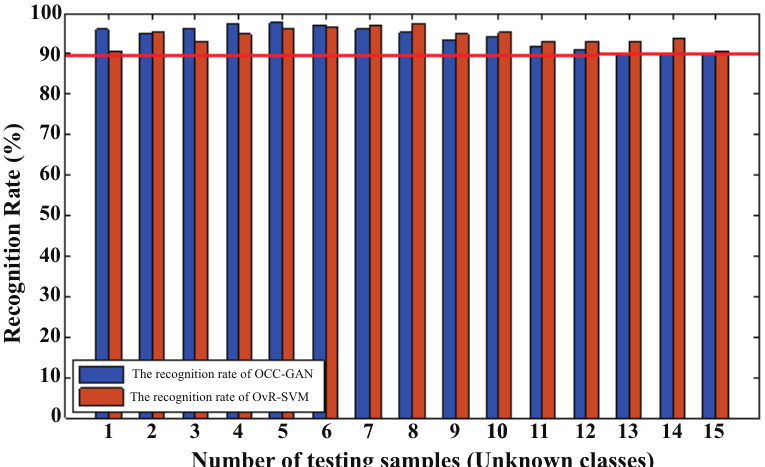
Figure 15. Comparison of the OvR-SVM and OCC-GAN